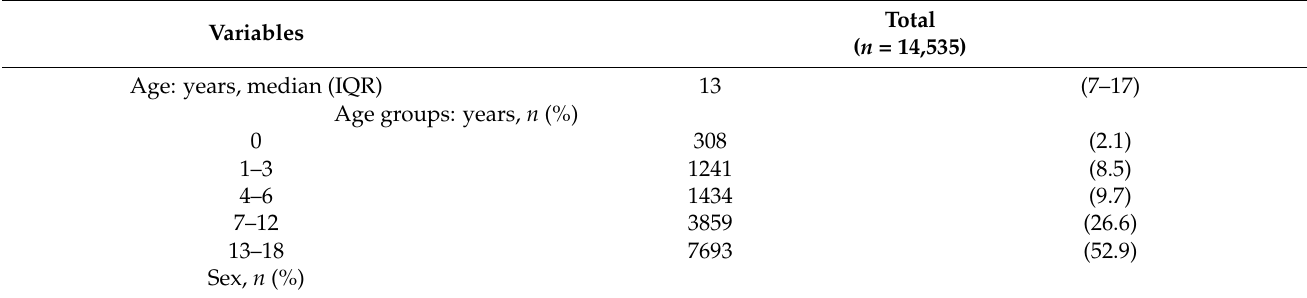
Table 1. Characteristics of the study population.